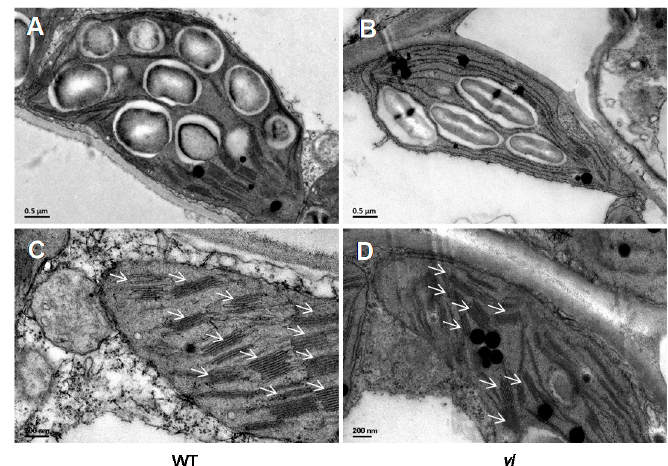
Figure 2. Chloroplast ultrastructure in the wild type and yl leaves. ( A , B ) Transmission electron micrographs (TEM) of chloroplasts in the wild type ( A ) and yl ( B ) leaves. ( C , D ) Magnified images of a chloroplast in the wild type ( C ) and yl ( D ) leaves. Arrows show grana. Bar = 0.5 µ m in ( A , B ) and 200 nm in ( C , D ).